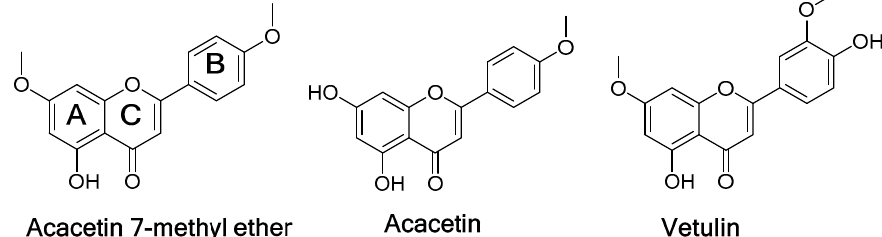
Figure 1. Chemical structure of acacetin, acacetin 7-methyl ether and vetulin.